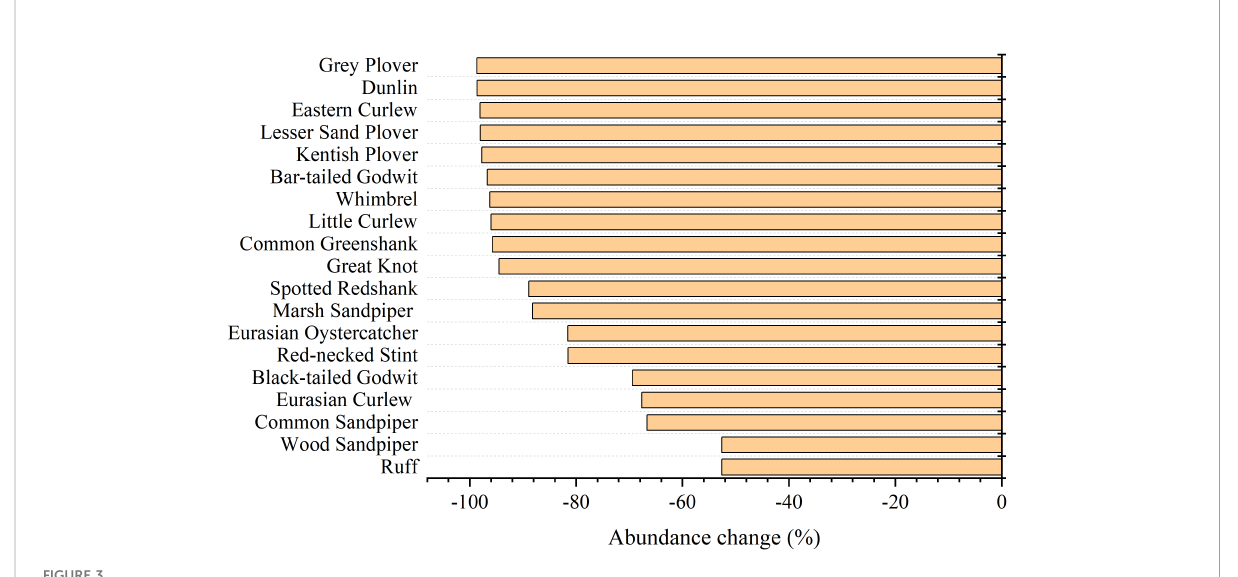
FIGURE 3 Changes in the abundance of shorebird species in the Yellow River Delta from 1995 to